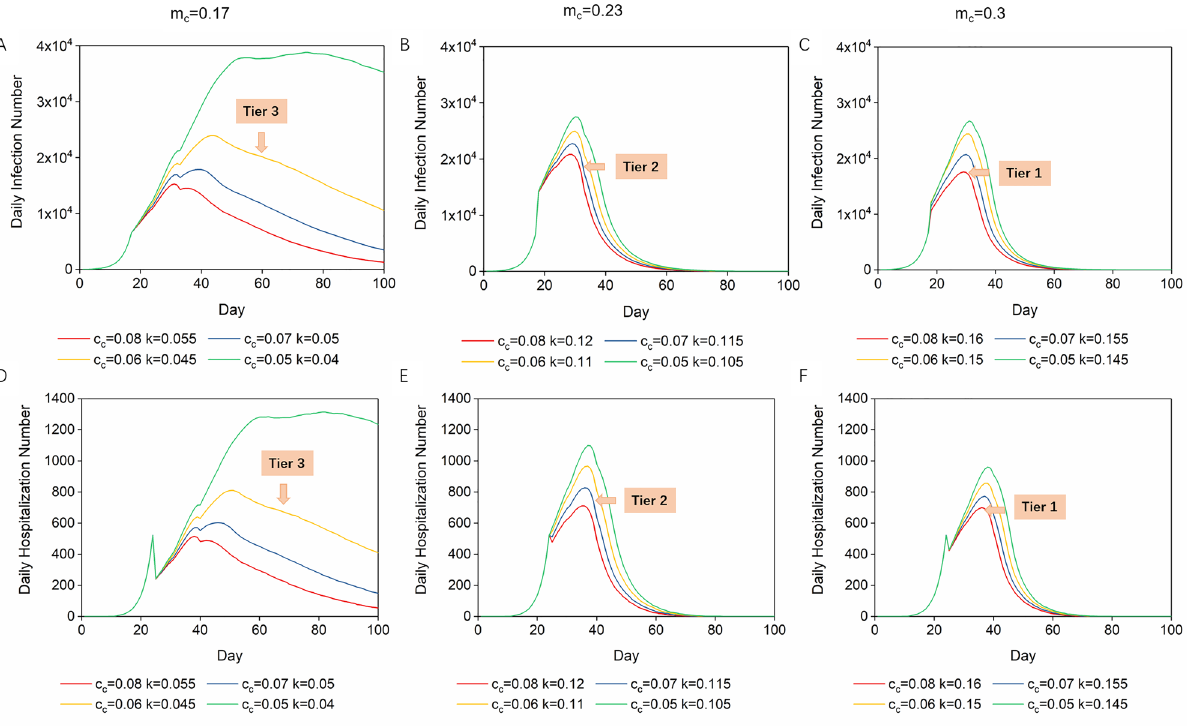
Figure 4. Daily infection curve and daily hospitalization curve with combined interventions. m c was in the range of 0.3–0.17 (initial R 0 in the range of 4.5–2.5), and c c was in the range 0.05–0.08 (20–32% people in the UK can travel over 2.5 miles a day). ( A ) Daily infection curves when m c was initially controlled at 0.17 (R 0 = 2.5). ( B ) Daily infection curves when m c was initially controlled at 0.23 (R 0 = 3.5). ( C ) Daily infection curves when m c was initially controlled at 0.3 (R 0 = 4.5). ( D ) When m c = 0.17, c c = 0.08–0.05, the number to hospital can be controlled at around 1000 when k is controlled at 0.055–0.045. ( E ) When m c = 0.23, c c = 0.08–0.05, the number to hospital can be controlled at around 1000 when k is controlled at 0.105–0.12. ( F ) When m c = 0.3, c c = 0.08– 0.05, the number to hospital can be controlled around 1000 when k is controlled at 0.16–0.145.